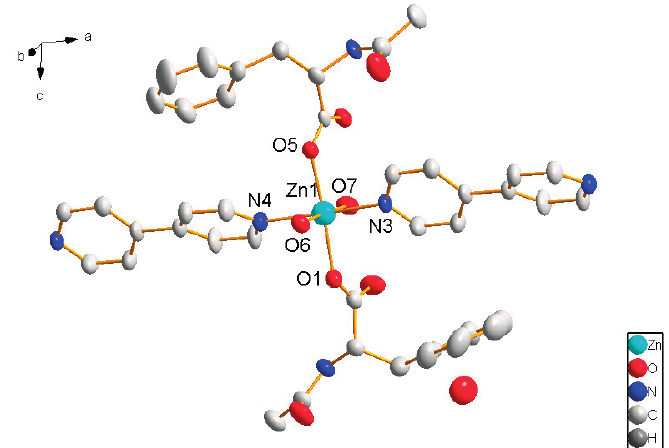
Figure 1. The coordination environment of Zn(II) in 1